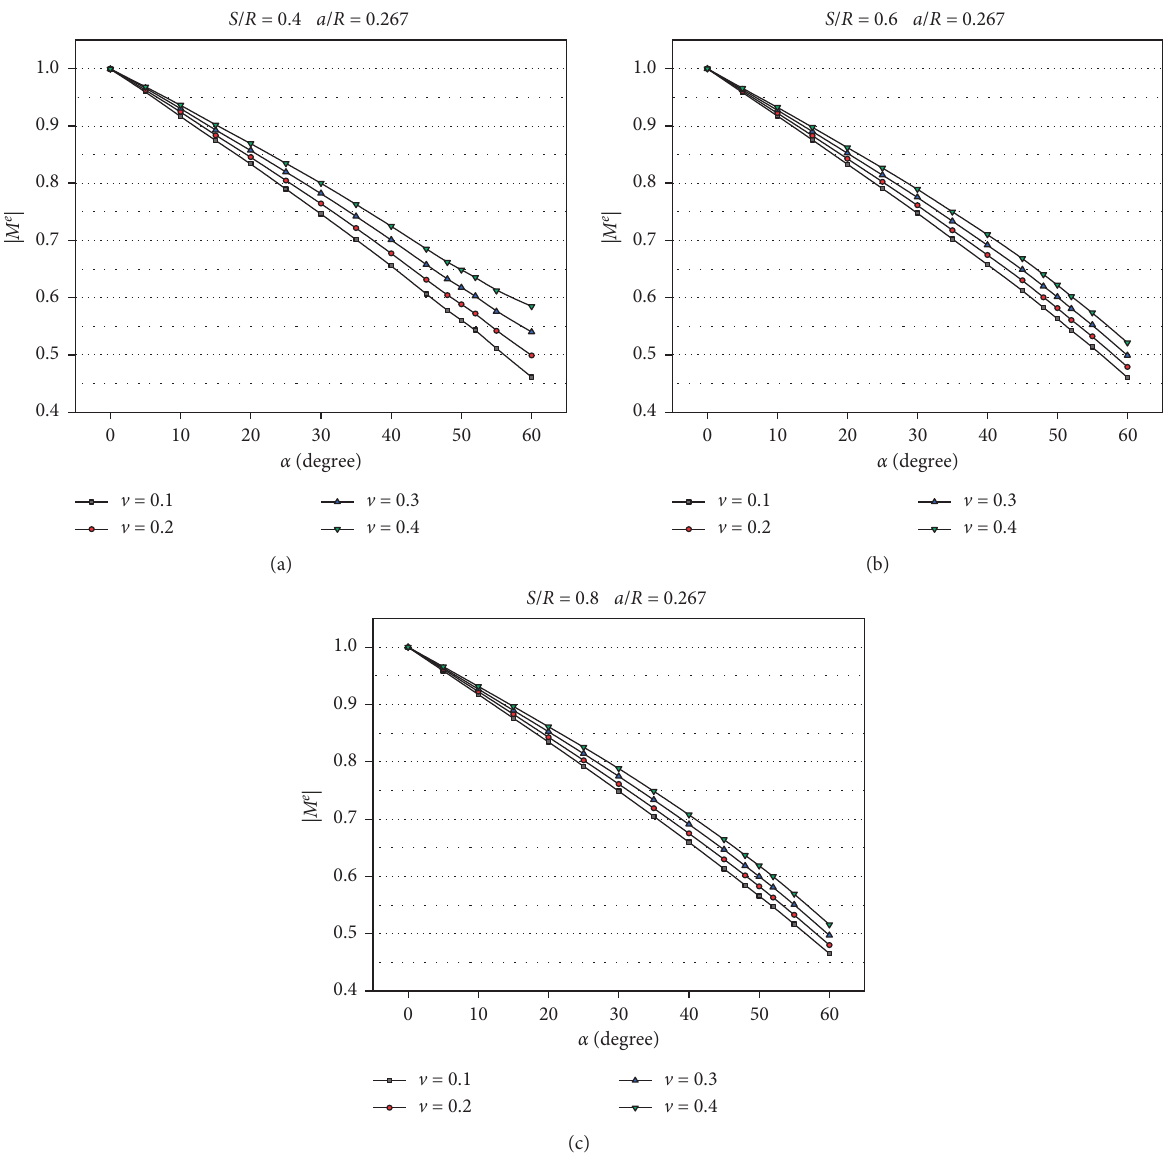
Figure 6: Variations of | M e | with α for different S / R and v values in the SCB